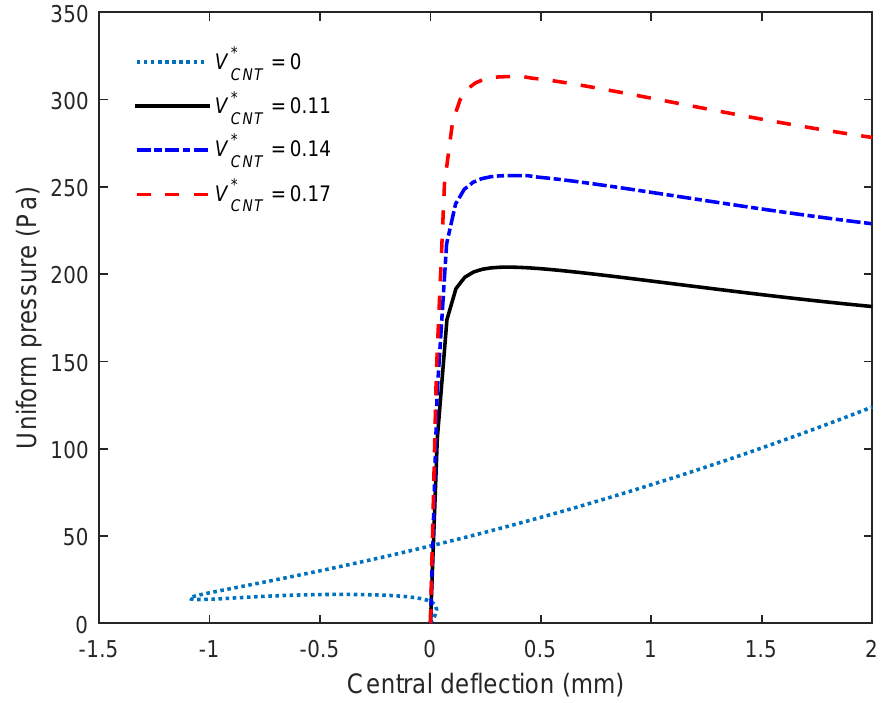
Figure 8. Effect of volume fraction on nonlinear response of the fully clamped FG-CNTRC cylindrical membrane with h = 0.5 mm, κ = 0.2, UD